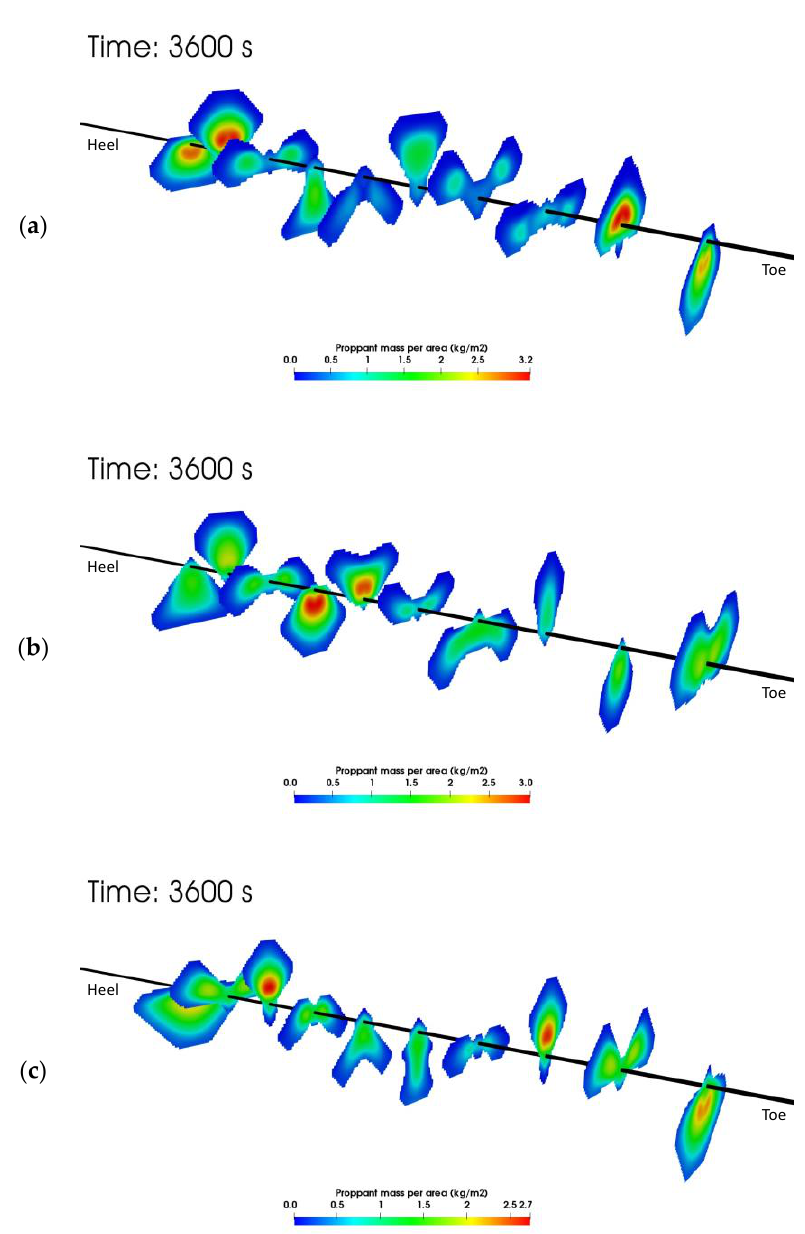
Figure 10. Proppant mass per unit fracture area distribution at the end of the one-hour injection. The axis scales along the wellbore direction have been exaggerated 6 times. ( a ) Case using slick water, ( b ) Case using NG foam, ( c ) Case using hybrid NG and NG foam.